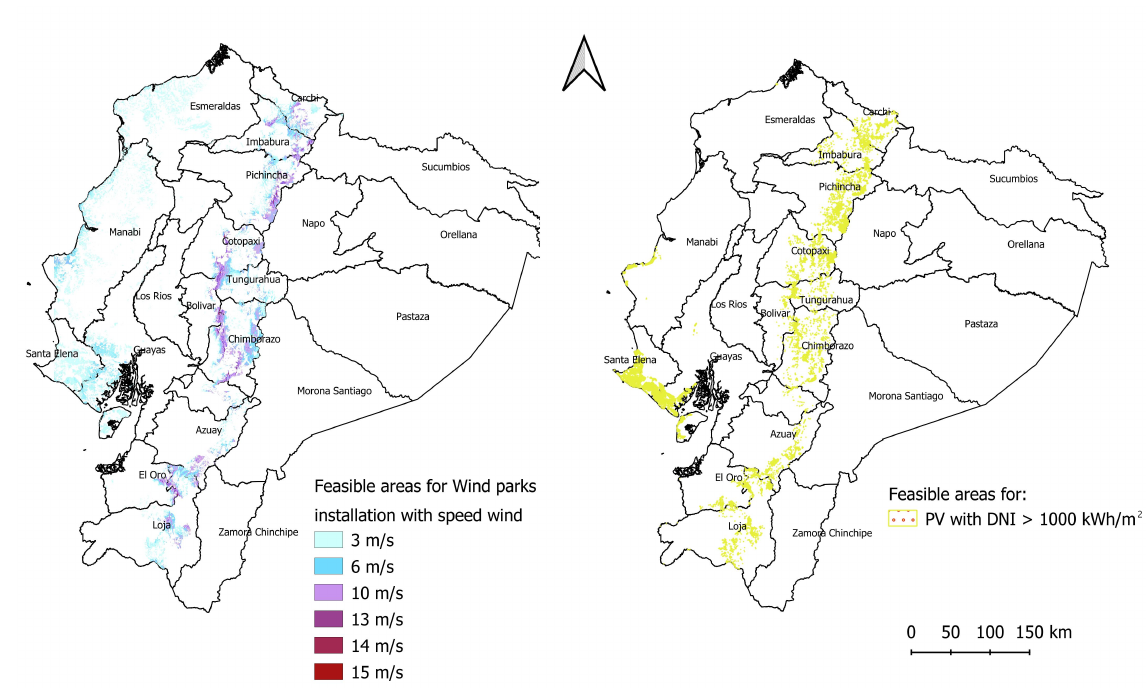
Figure 5. Feasible areas for wind parks with wind speed higher than 3 m/s. and for photovoltaic plants with DNI higher than 1000 kWh/m 2 [57].